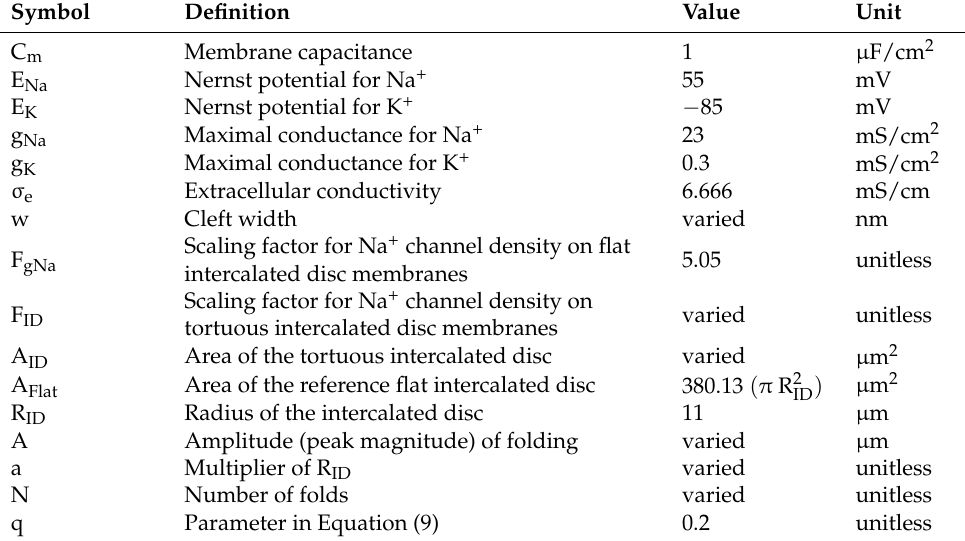
Table 1. Electrical and geometrical model parameters including symbol, definition, value and